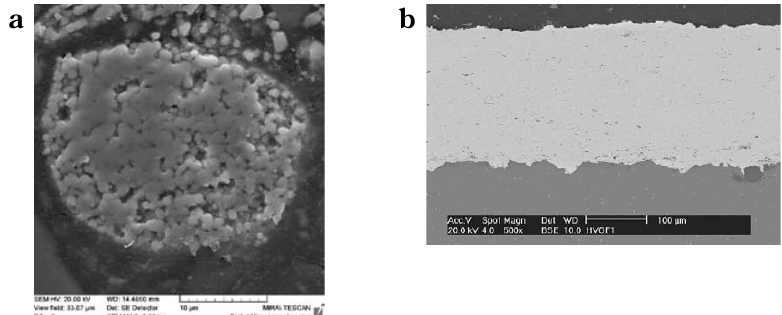
Fig.8 Cross-sections of (Ni,Zn,Co,Mn)Fe 2 O 4 powder (a) and HVOF coating from it (b 105 ).